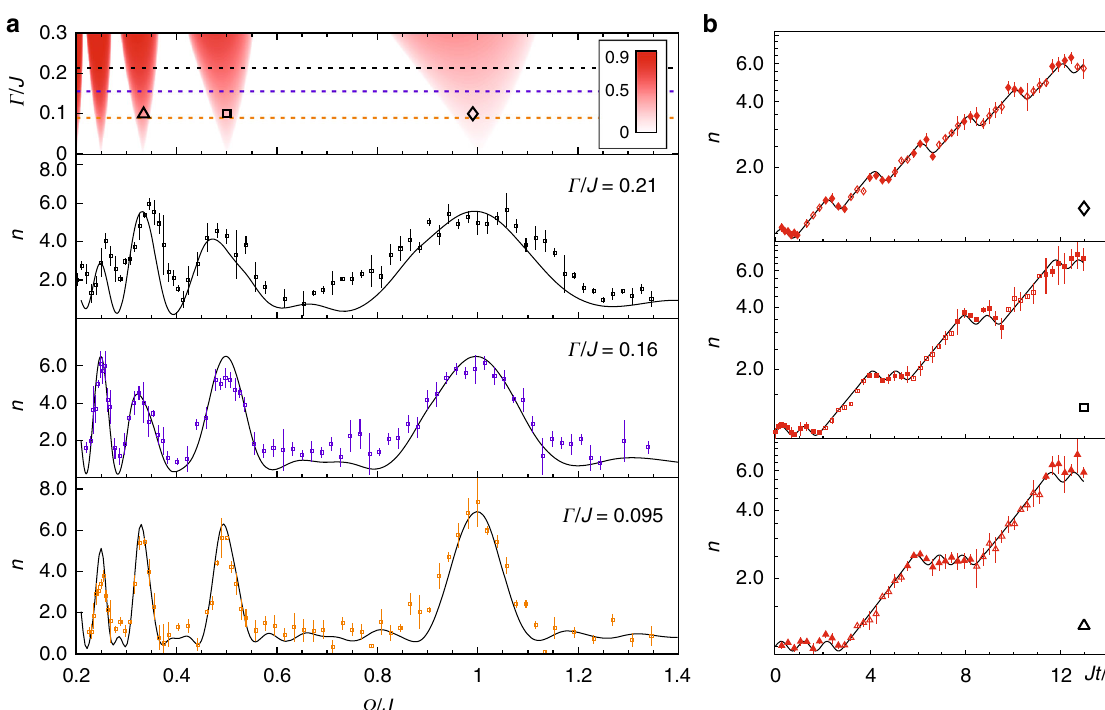
Fig. 3 Detecting multiphoton resonances with time-periodic coupling. a The top frame is the phase diagram. n ( t f , Ω ) are shown below. From the second top frame to the bottom one, Γ / J = 0.21, 0.16, 0.095, t f = 2.70, 3.70,6.48 ms respectively. The side peaks are mainly due to the fi nite probe time. b n ( t ) with Γ / J = 0.095 at the resonant peak Ω = J , J /2, J /3 from the top to bottom frame. The data with solid shapes corresponds with the dissipation on, the data with n empty shapes are with the dissipation off. For all fi gures, solid curves are the numerical simulation without free parameters. The initial phases of the square-wave modulation are set to zero. The error bars represent the standard deviation of the